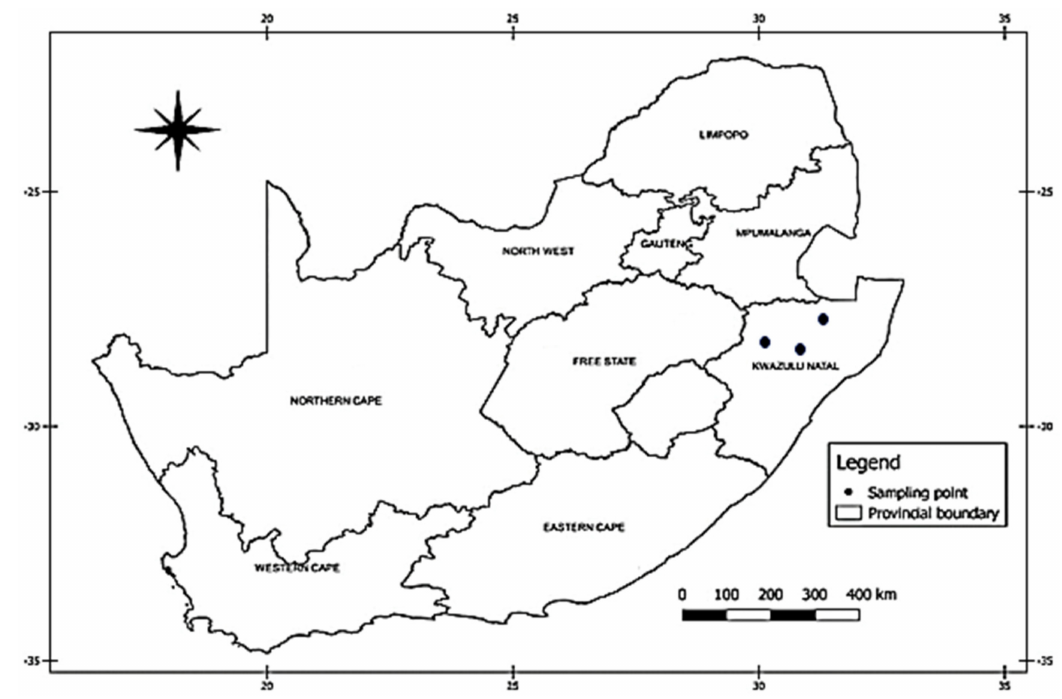
Figure 1. Study sites. Source: Geographic Information Systems [21]. Table 1. Sample